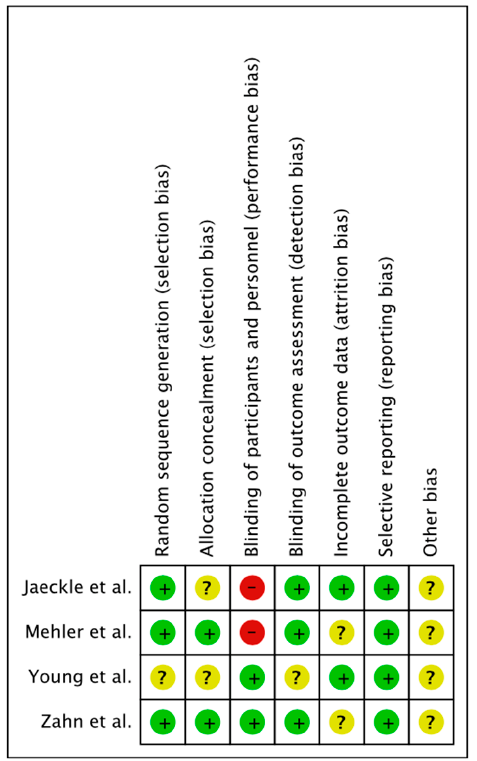
Figure 3. Risk of bias summary. Review authors ’ judgements about each risk of bias item for each included study assessed by ROB − 1 tool. Green (+): Low risk of bias; Yellow (?): Unclear risk of bias; Red(-): High risk of bias.